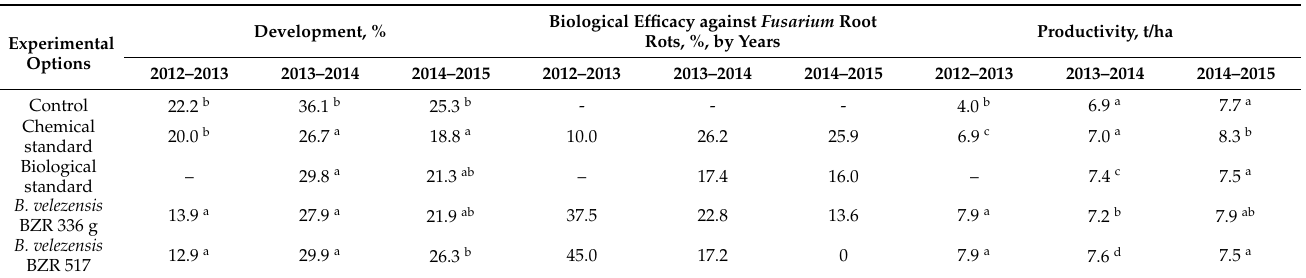
Table 3. Biological efficacy (BE, %) and yield of winter wheat of Kalym cultivar treated with BZR 336 g and BZR 517 under stationary crop rotation,